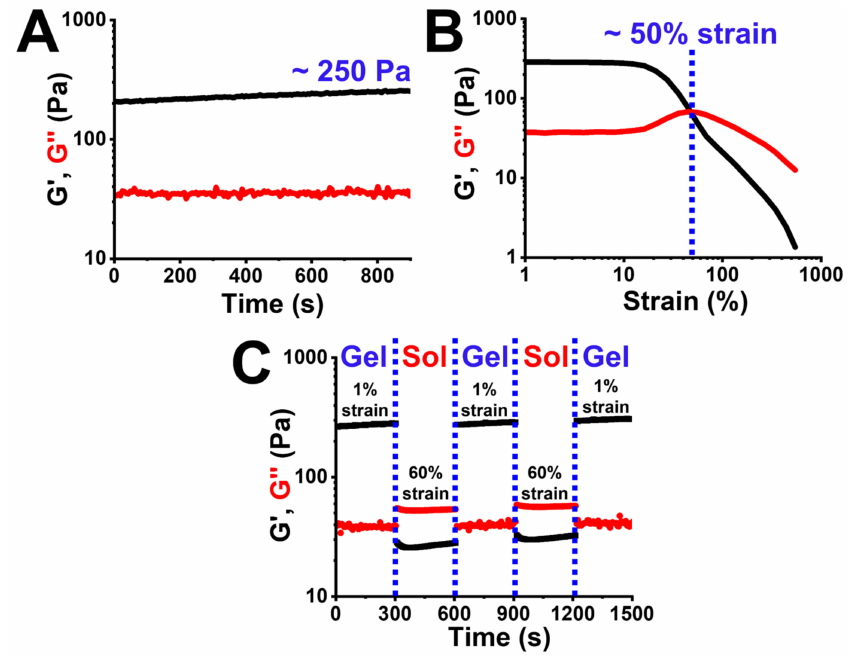
Figure 4. Rheological properties of the self-healing recombinant spider silk hydrogel at 25 ◦ C. ( A ) The time-dependent moduli (G (cid:48) and G (cid:48)(cid:48) ) of the hydrogel were measured at 1% strain and 1 Hz. ( B ) The strain-dependent moduli (G (cid:48) and G (cid:48)(cid:48) ) were measured at 1 Hz. ( C ) The damaging-healing property of the self-healing recombinant spider silk hydrogel was measured through the continuous step changes of oscillatory strain at 1 Hz.